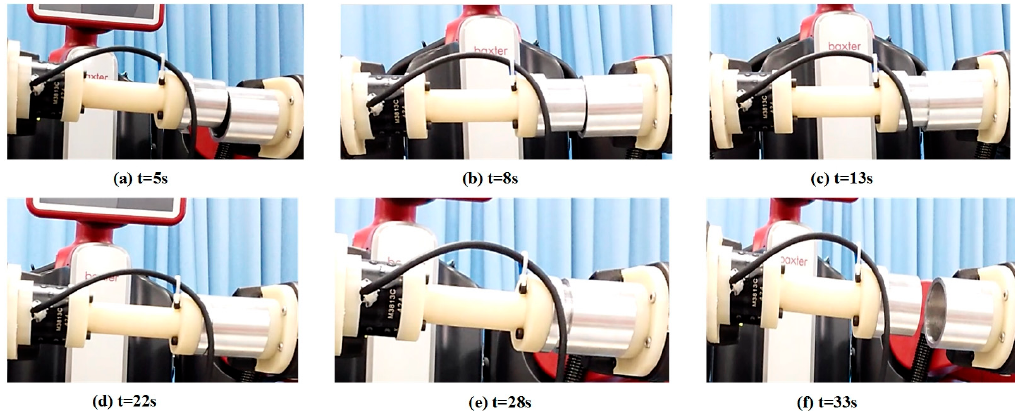
Figure 17. Round pieces: the process of peg-in-hole assembly with dual-arm operation.